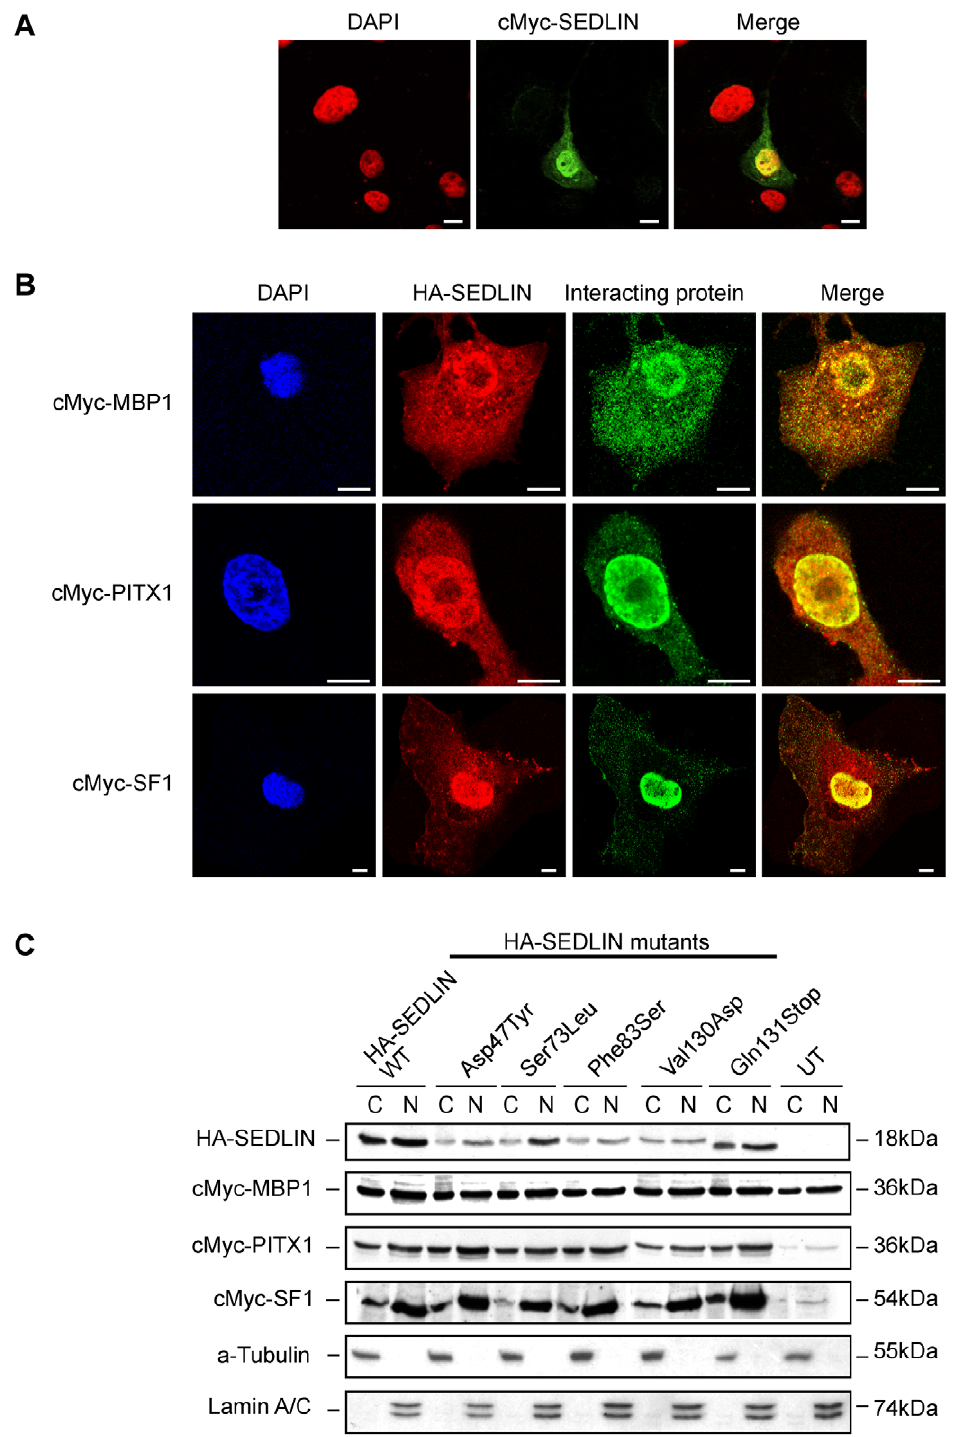
Figure 3. Subcellular co-localization of wild-type and mutant SEDLINs, MBP1, PITX1 and SF1. (A) COS7 cells were transfected with wild- type or mutant (Asp47Tyr, Ser73Leu, Phe83Ser, Val130Asp and Gln131Stop) cMyc-SEDLIN constructs and visualised by immunofluorescence. The wild-type cMyc-SEDLIN (green) and mutant forms (data not shown) were found to localize to the nucleus and cytoplasm. DAPI, which stains nuclei (shown as red), colocalized with SEDLIN (yellow in merged image). (B) Wild-type or mutant HA-SEDLINs (red) were co-transfected with cMyc-MBP1, cMyc-PITX1 or cMyc-SF1 constructs and visualized by immunofluorescence (green). Wild-type SEDLIN and mutant SEDLINs (data not shown) co- localized (yellow) to the nucleus with the three transcription factors and to punctate structures within the cytoplasm with MBP1. (C) Western blot analysis of subcellular fractions (N - nuclear, C–cytoplasmic) from COS7 cells transiently co-transfected with wild-type (WT) or one of the 5 mutant HA- SEDLIN constructs, and cMyc-MBP1, cMyc-PITX1 or cMyc-SF1 constructs. Use of anti-HA antibody detected the expected 18 kDa wild-type and mutant SEDLIN proteins, and anti-cMyc antibody detected the expected 36 kDa, 36 kDa and 54 kDa MBP1, PITX1 and SF1 proteins, respectively,